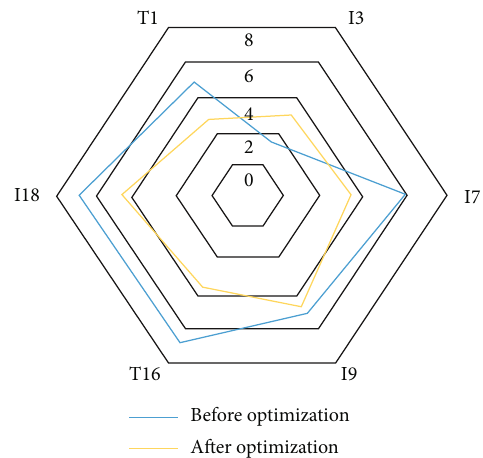
Figure 8: Mathematical model for congested road tra ffi c optimization before and after the extension time radar map.